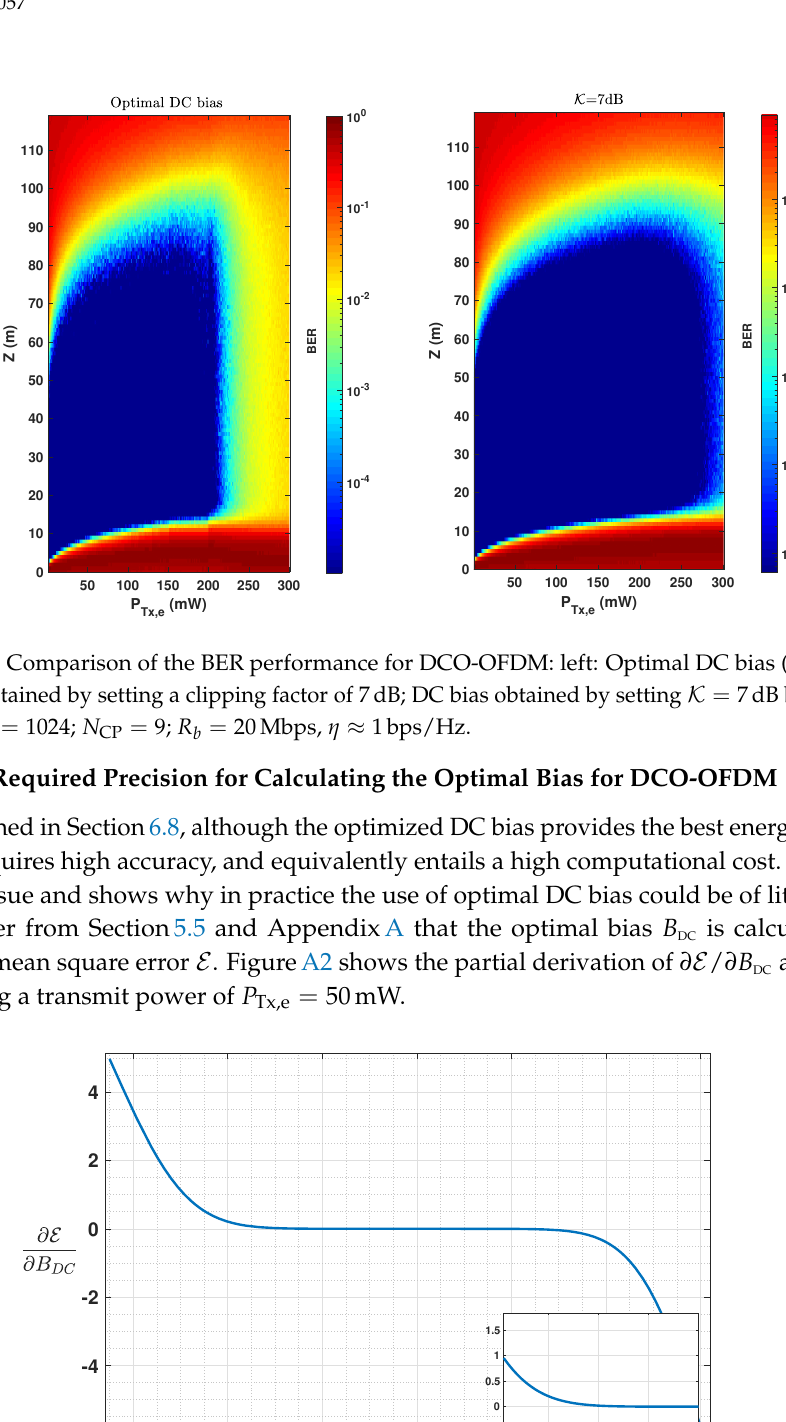
for calculating the optimal bias for DCO-OFDM. DC